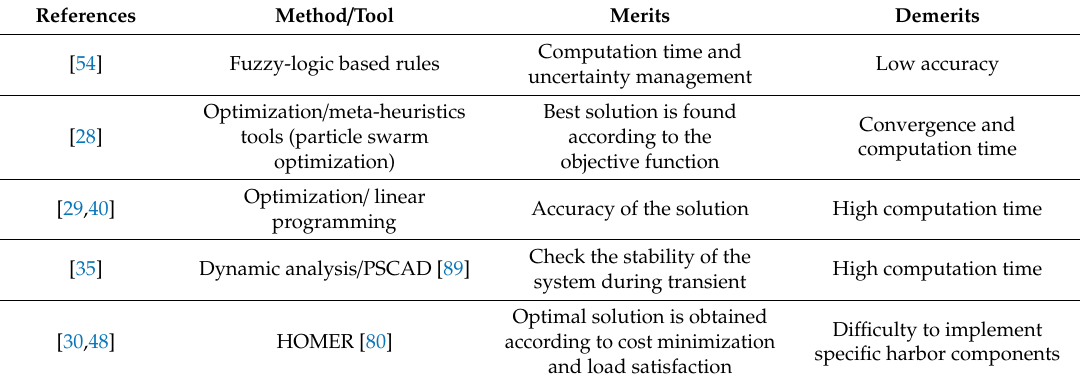
Table 3. Methods and tools used in articles dealing with energy management of harbor microgrids